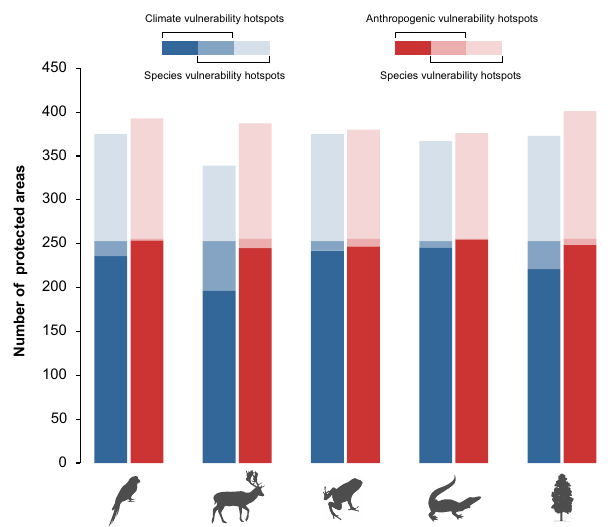
Fig. 3 Overlap of species vulnerability hotspots of fi ve species groups with climate and anthropogenic vulnerability hotspots. The hotspots were identi fi ed by randomizing respective vulnerability scores of each protected area (PA) 1000 times and keeping a track of where the observed value was greater than the randomized value. If the observed value was within the highest 5% of the null distribution (one-tailed test) for that PA (i.e., at least 950 times higher than the 1000 randomized value), it was identi fi ed as hotspots.